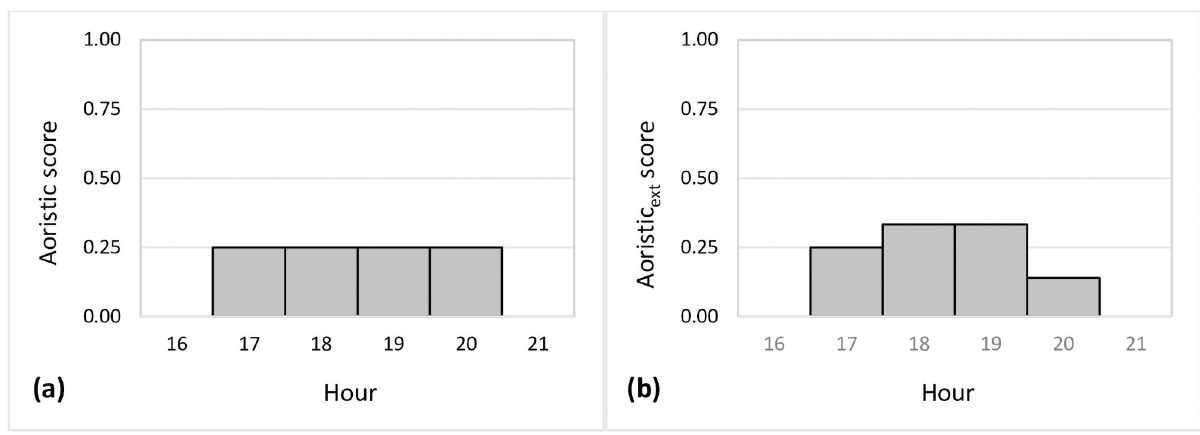
Fig 2. Distribution of scores of the aoristic (a) and aoristic ext (b) methods to estimate offense times.